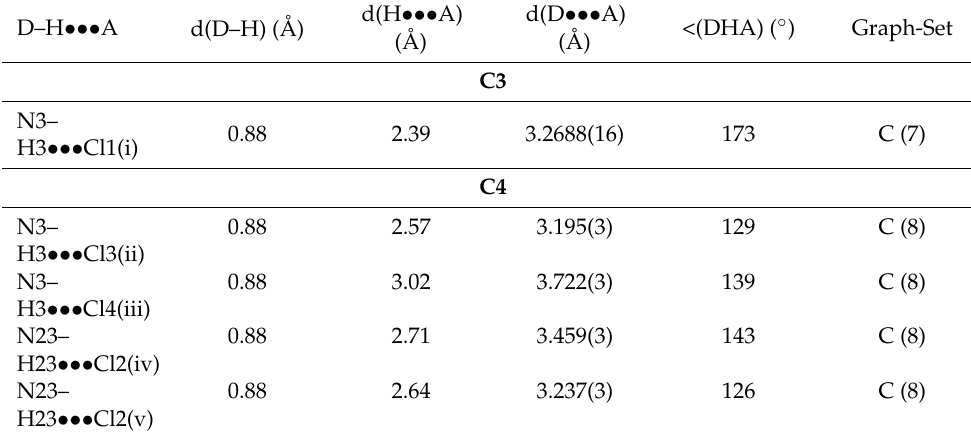
Table 7. Hydrogen bonds in the structures of C3 and C4